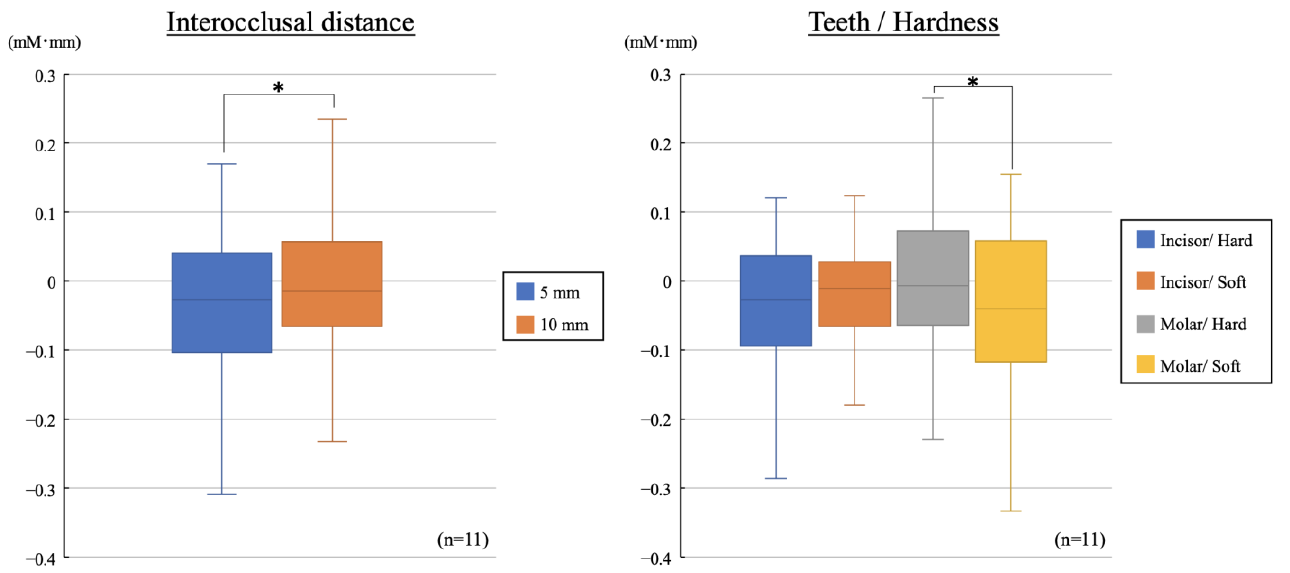
Figure 3. Changes in the cerebral blood flow for different interocclusal distance, teeth type, and block hardness (* p < 0.05, unpaired t -test).